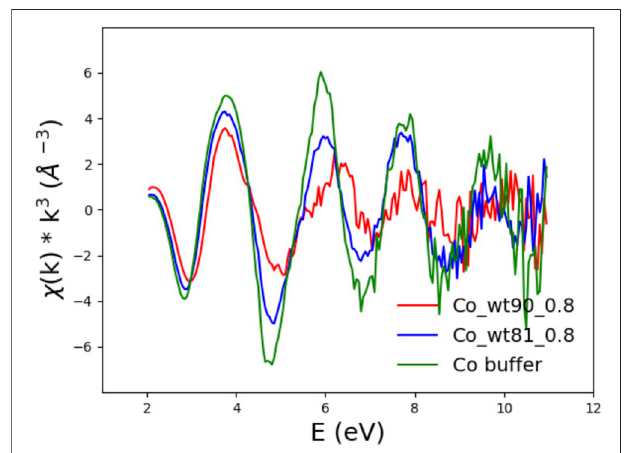
FIGURE8| EXAFSspectraofFXNwt_90_0.8(red)andwt_81_0.8(blue) in the presence of 0.8 Co 2+ equiv compared to the buffer spectrum